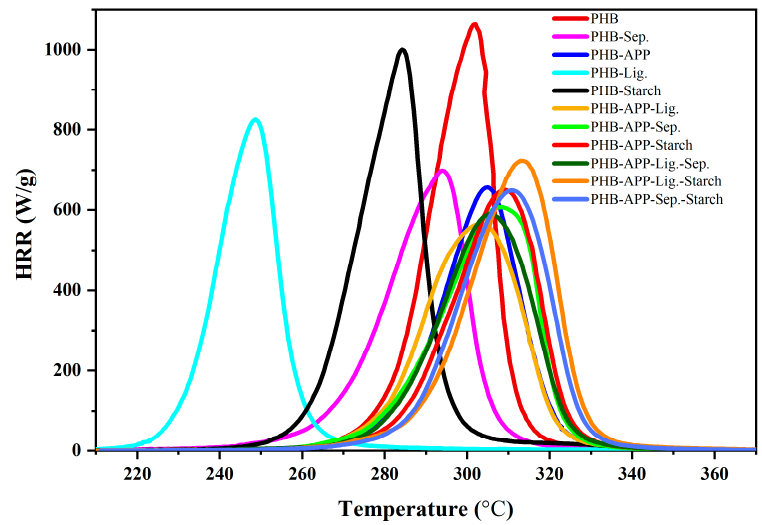
Figure 1. Heat Release Rate (HRR) curves obtained in PCFC tests. Table 2. Names and compositions of selected samples after screening study.